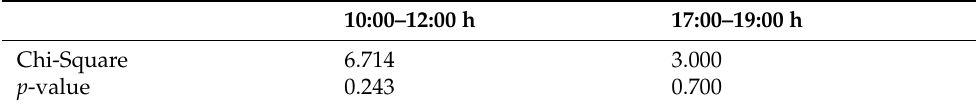
Table 11. Difference in electric field measurements across locations (Kruskal Wallis Test).